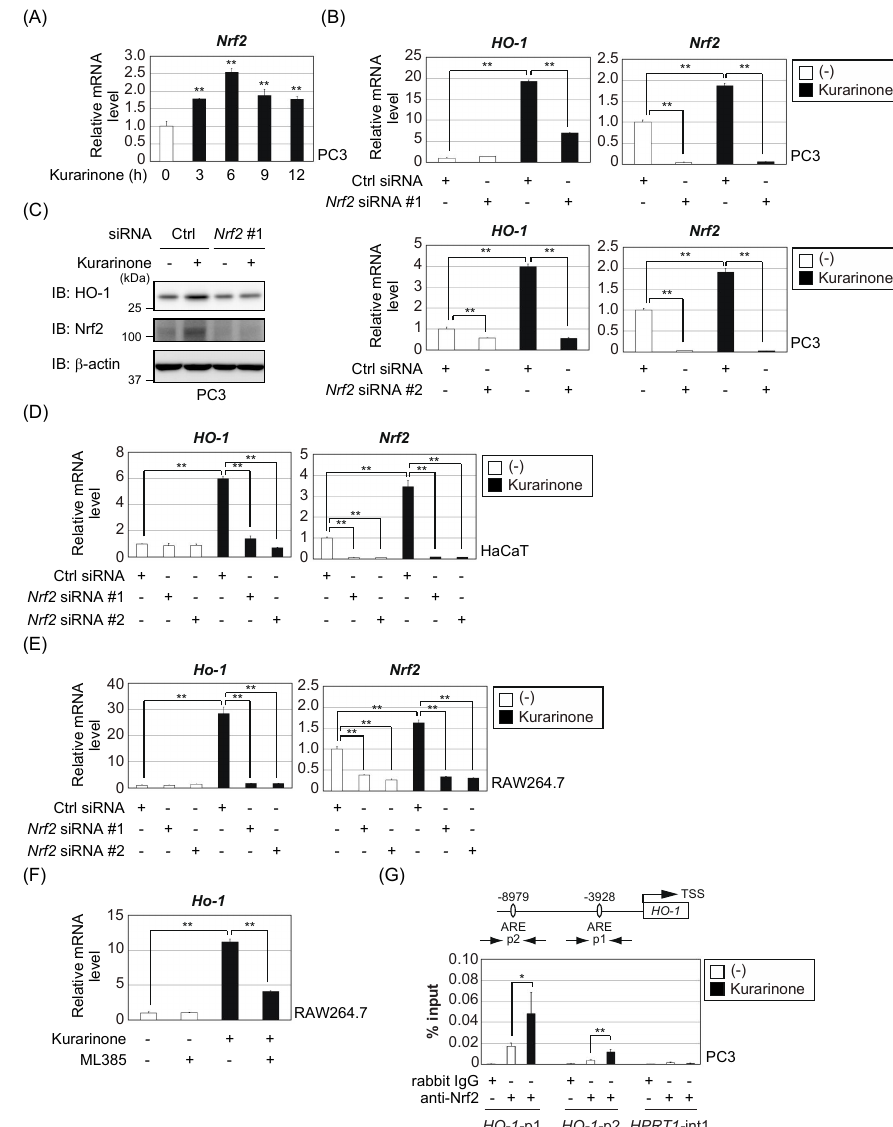
Figure 2. Kurarinone induces HO-1 expression in an Nrf2-dependent manner. ( A ) PC3 cells were treated with 50 μM kurarinone for the indicated periods. The expression of Nrf2 mRNA was assessed by qPCR. Results were shown as the mean ± S.D. ( n = 3). Significant differences are indicated as ** p < 0.01 vs. the group without kurarinone-treatment. ( B , C ) PC3 cells were transiently transfected with the indicated siRNAs. After 48 h, the cells were treated with 50 μM kurarinone for 6 h. (B) The expression level of each gene was assessed by qPCR. Results were shown as the mean ± S.D. ( n = 3). Significant differences are indicated as ** p < 0.01. (C) Cell lysates were immunoblotted with the indicated antibodies. Ctrl, control. ( D ) HaCaT cells were transiently transfected with the indicated siRNAs. After 48 h, the cells were treated with 50 μM kurarinone for 6 h. The expression level of each gene was assessed by qPCR, as in (B). ( E ) RAW264.7 cells were electroporated with the indicated siRNAs. After 48 h, the cells were treated with 50 μM kurarinone for 12 h. The expression level of